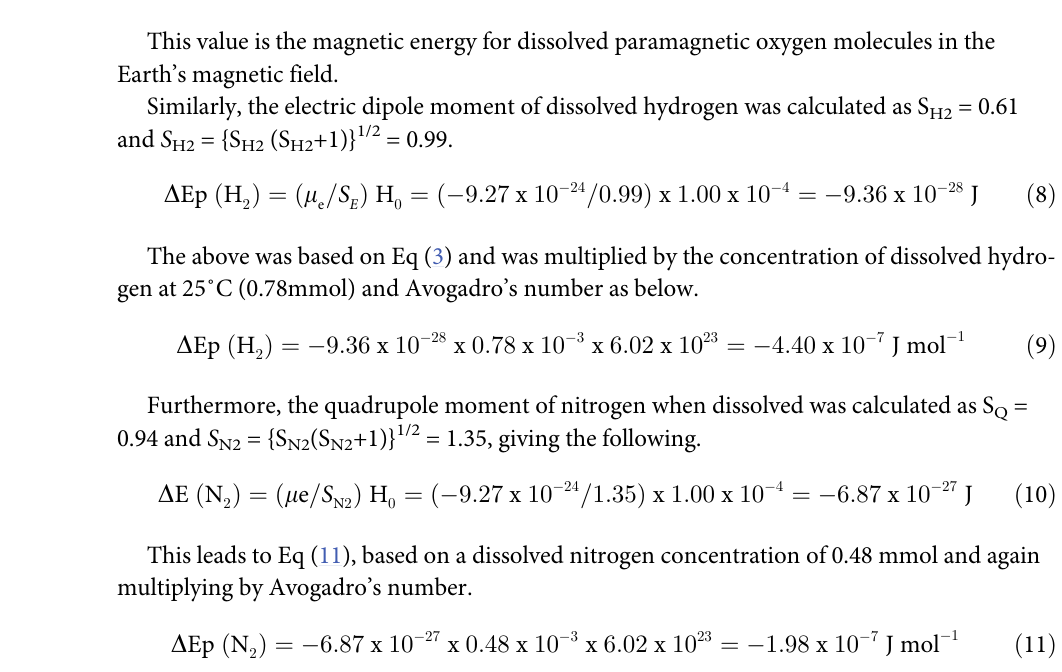
Fig 2. Arrhenius plots for dissolved gases in pure water. Legend: ◆ : O 2 , ■ : H 2 , ▲ : N 2 .